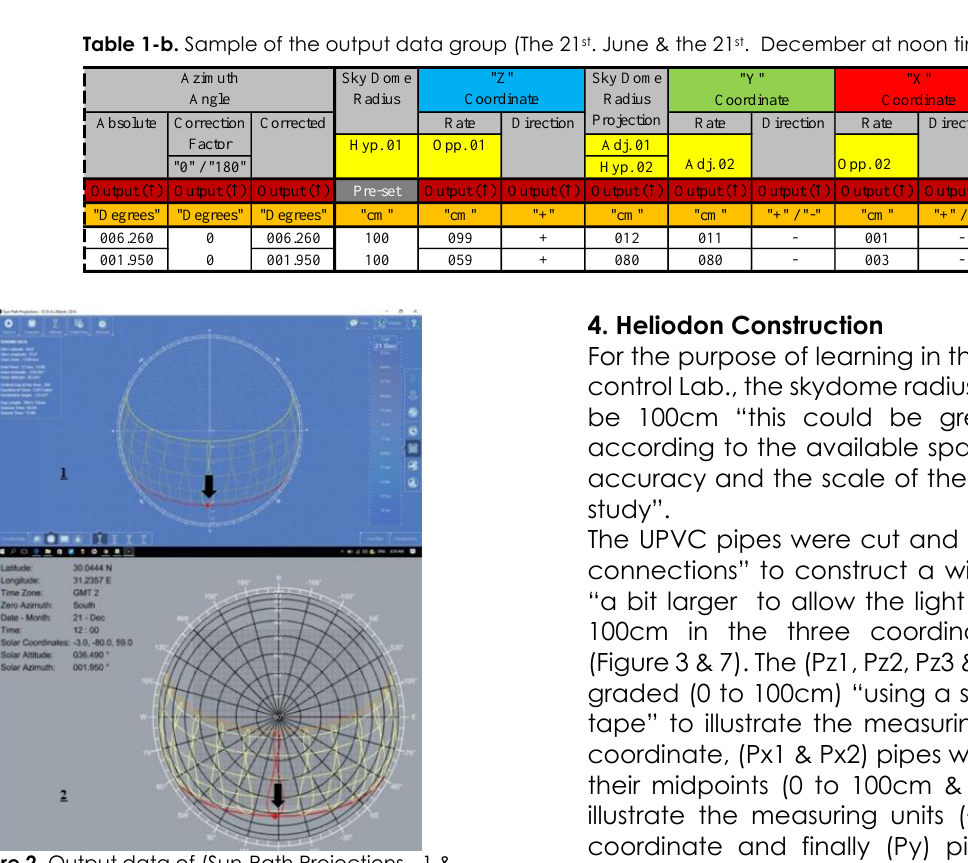
Figure 2. Output data of (Sun-Path Projections - 1 & Grasshopper - 2) at noon time, 21 st . December for Cairo –